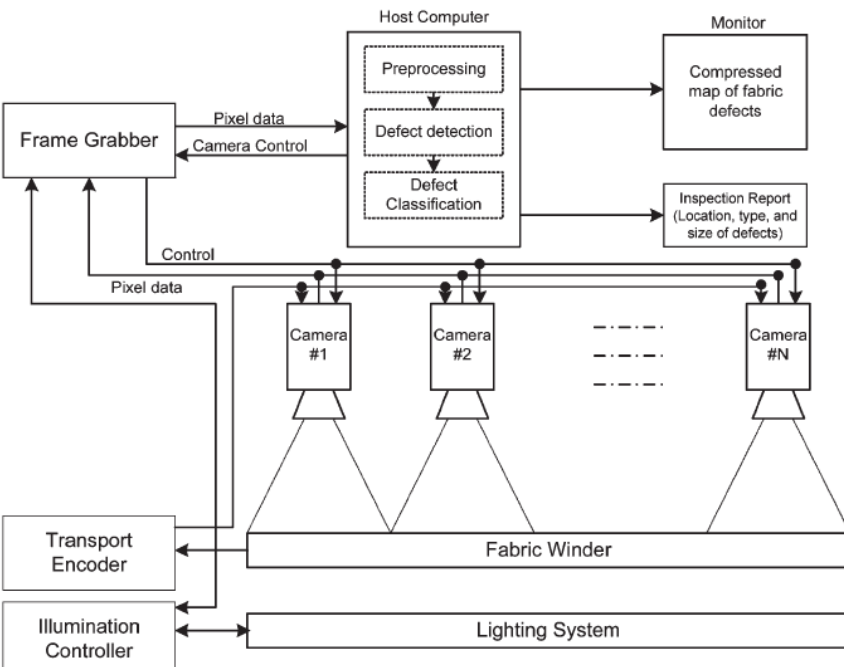
Figure 1. PC-based fabric inspection